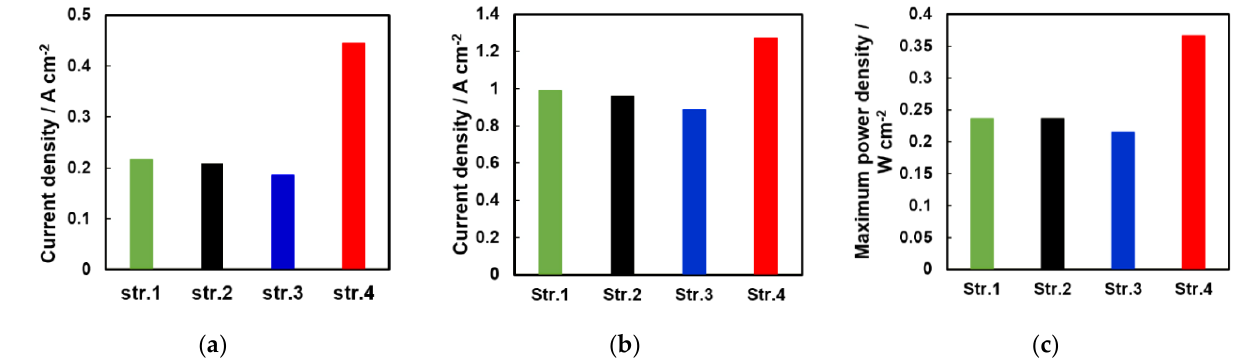
Figure 9. Performance of the four CCLs at ( a ) 0.6 V and ( b ) 0.2 V and the ( c ) maximum power density at 40% RH.